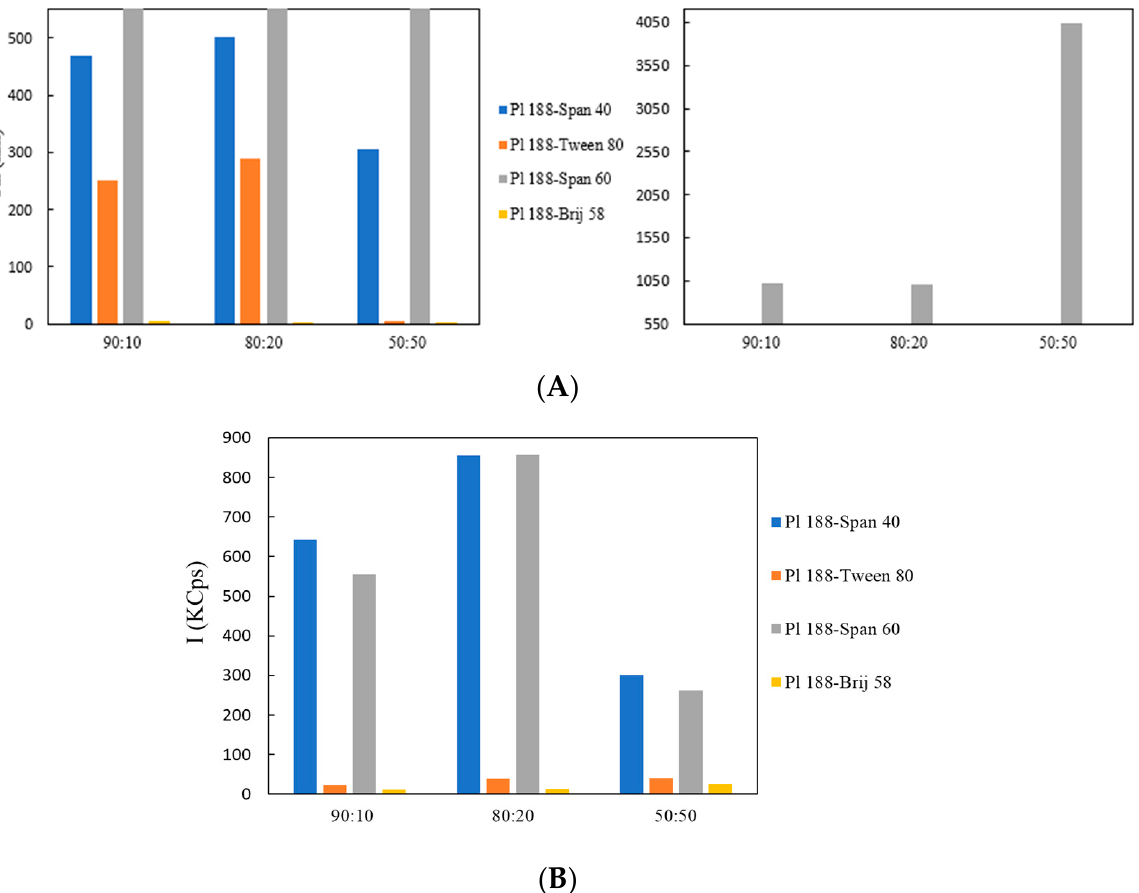
Figure 1. ( A ) Hydrodynamic diameter R h (nm) and ( B ) Scattering Intensity, I (KCps) of Poloxamer 188-Span 40 ® (blue bars); Poloxamer-Tween 80 ® (orange bars); Poloxamer-Span 60 ® (grey bars); and Poloxamer-Brij 58 (yellow bars) at different weight ratios.